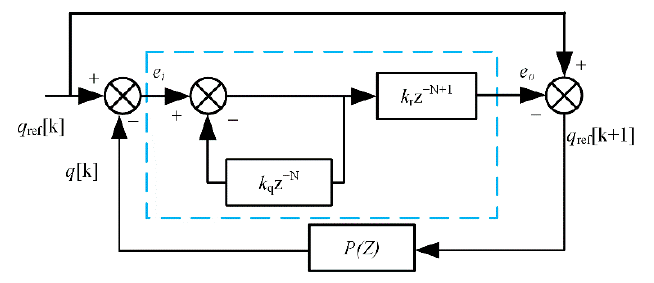
Figure 5. Repetitive control system.